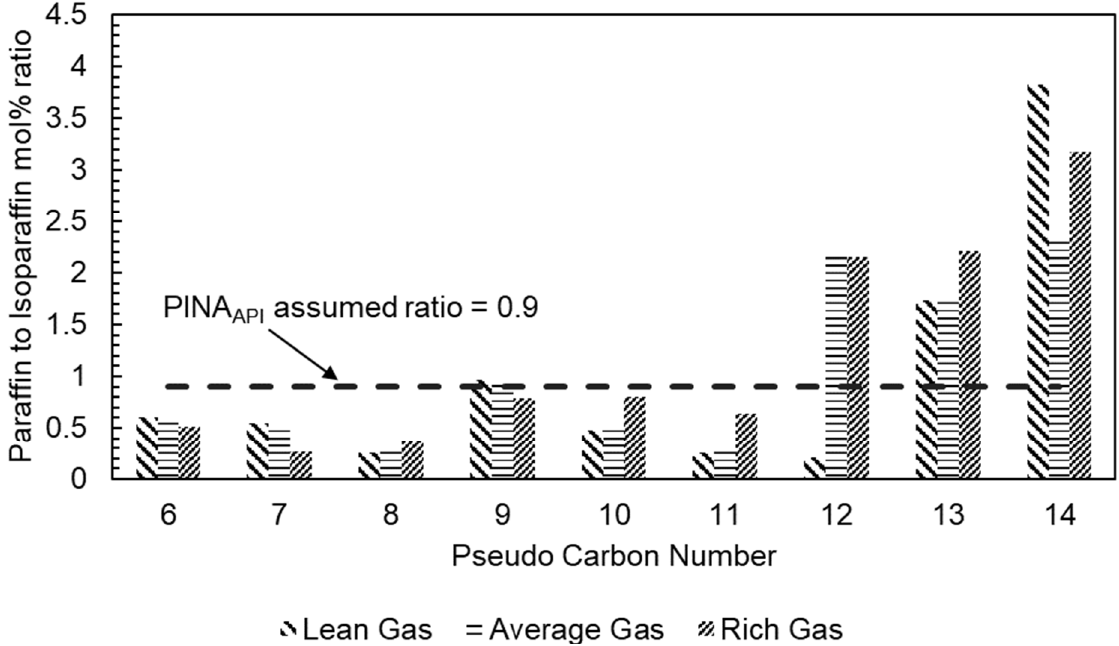
Figure 3. Average ratios of paraffin to isoparaffin mole fraction in each single carbon number pseudocomponent for each gas mixture type across the 46 gas samples analyzed in this work. The dotted line represents the fixed ratio assumed in the PINA API approach detailed by Miethe et al. [6].